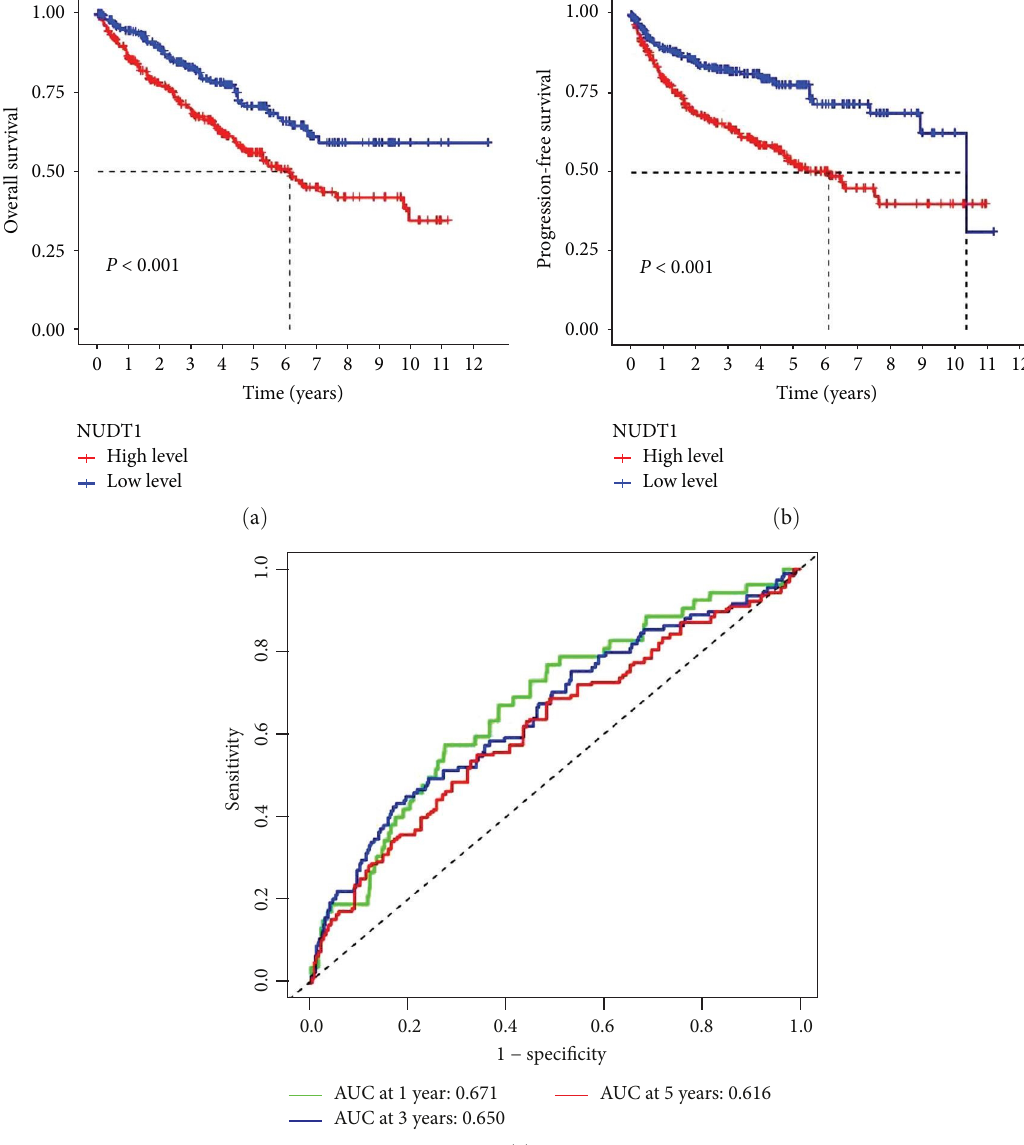
F IGURE 3: Evaluation of NUDT1 expression on survival of patients with ccRCC: (a) Kaplan – Meier analysis of overall survival based on NUDT1 expression; (b) Kaplan – Meier analysis of progression-free survival based on NUDT1 expression; (c) the areas under the ROC curve about 1, 3, and 5